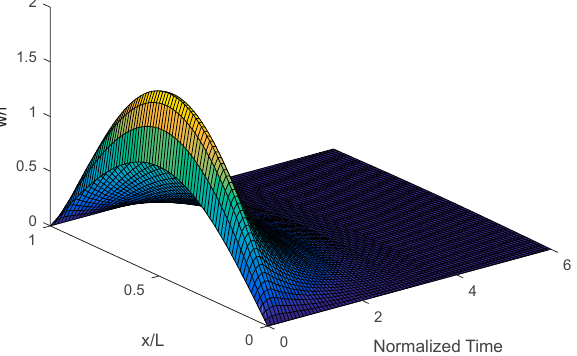
Figure 7. Time history of deflection of the nano-beam using the proposed control scheme in the presence of disturbances and faults in the actuator.